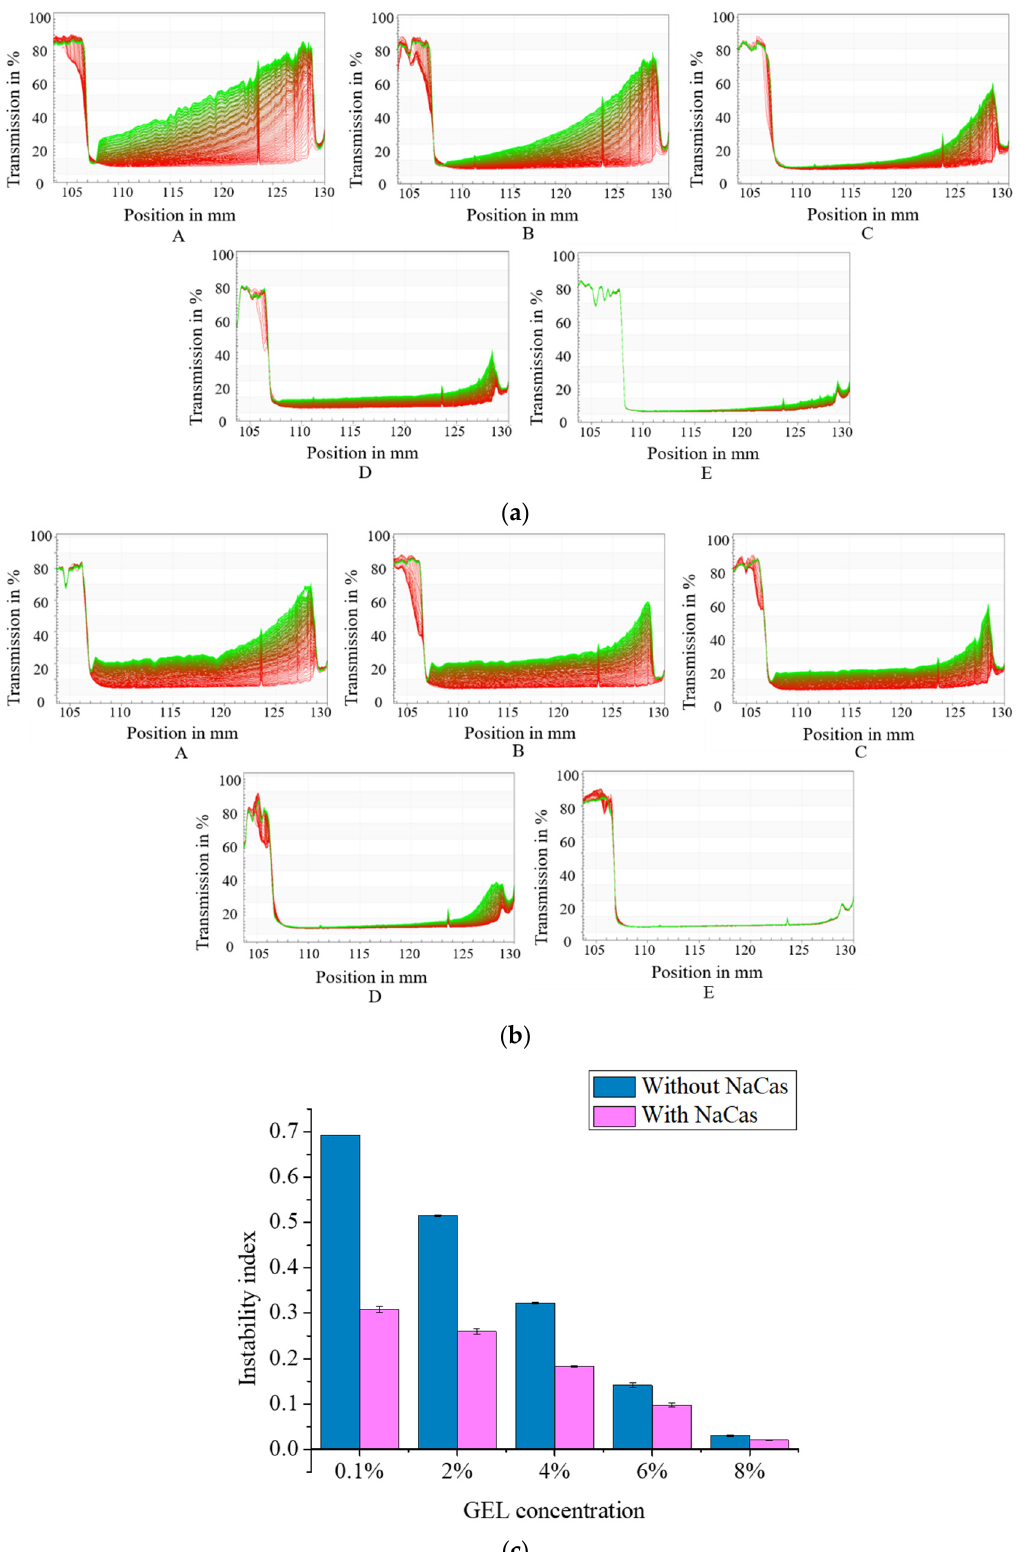
Figure 1. LUMiSizer analysis of CaCO 3 S/O/W emulsions prepared by different GEL concentrations (0.1, 2, 4, 6, 8 wt%): ( a ) without NaCas; ( b ) with NaCas; ( c ) instability index. The red and green sections are all the transmittance curves.